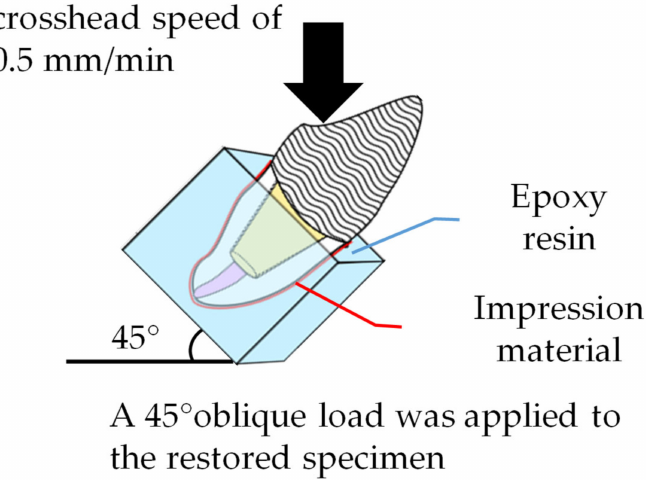
Figure 3. Fracture loads of bovine roots restored with fiber-reinforced post-cores and zirconia crowns. The results were analyzed by conducting Student’s t -test at a significance level of 95% (IBM SPSS Statistics Version 22, IL,